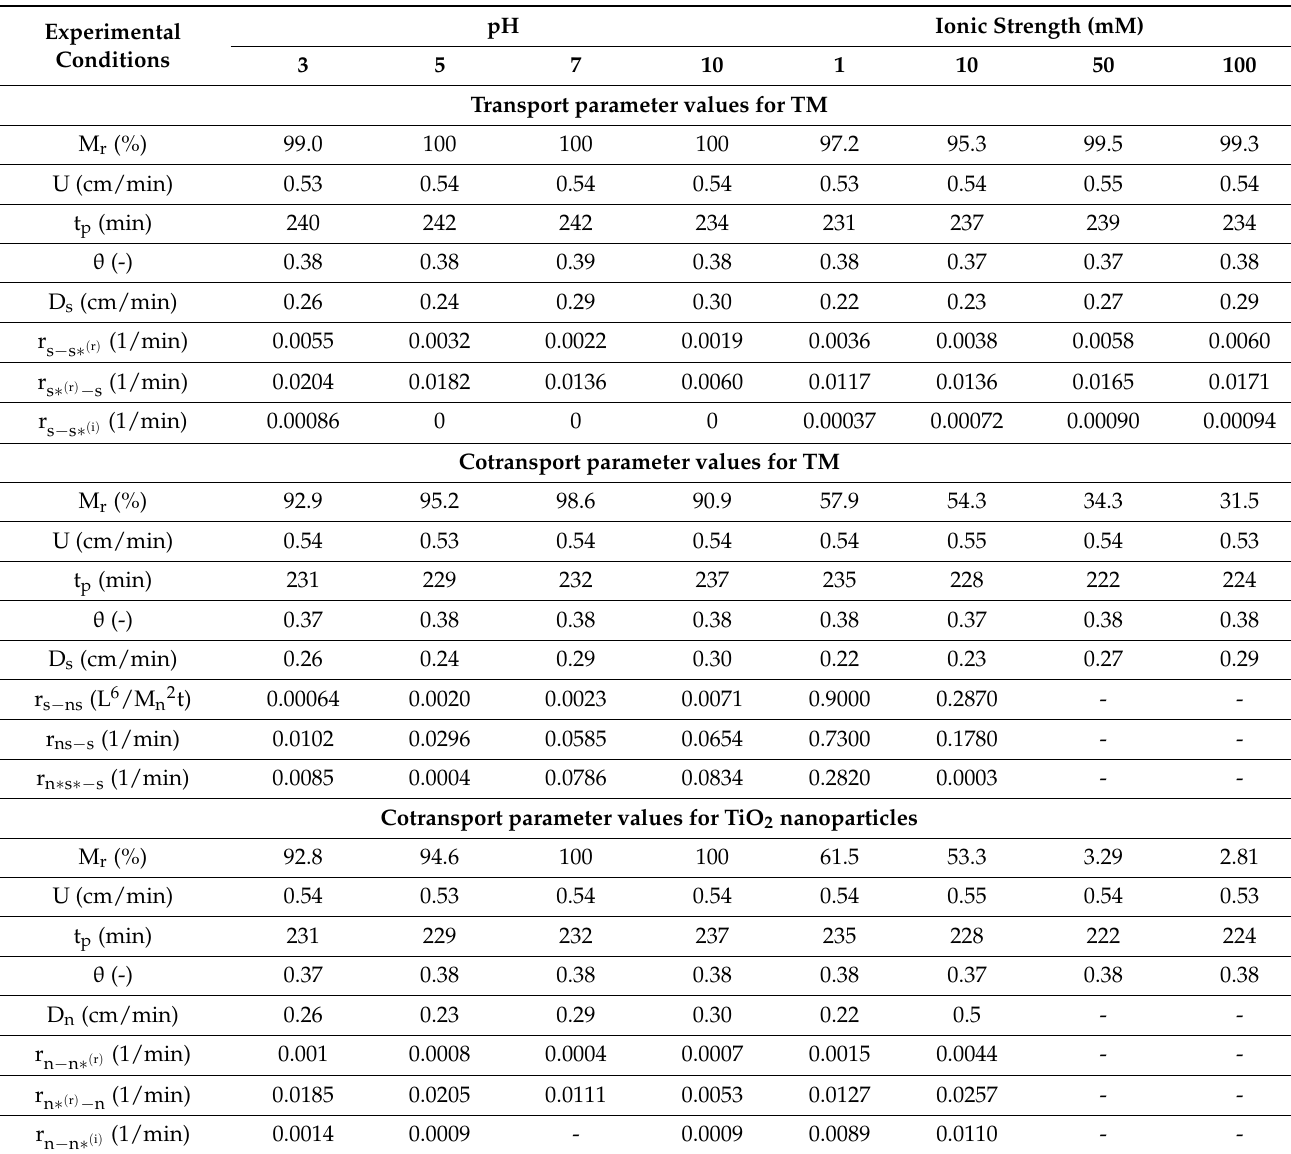
Table 2. Transport and cotransport measured and fitted parameter values for Q = 1